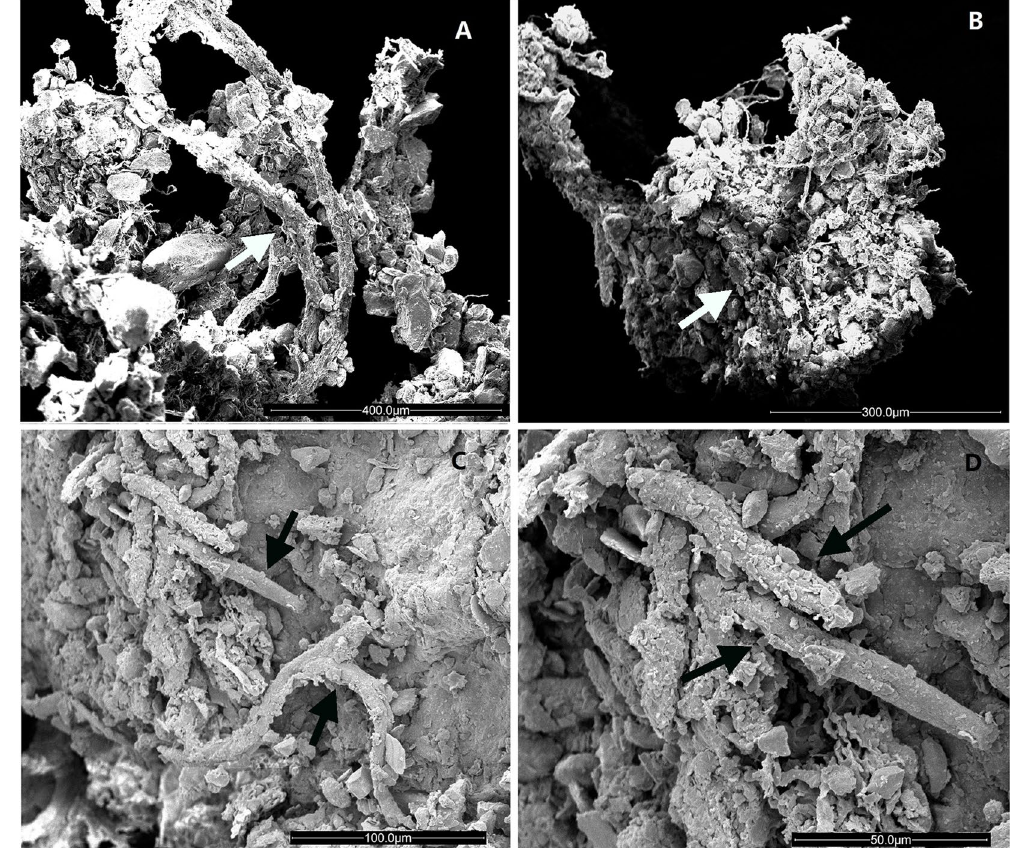
Figure 3. SEM images of thallus rhizines binding sand particles. ( A , B ) Endocarpon deserticola (holotype, Z07090); ( C , D ) Endocarpon unifoliatum (holotype, Z10020). Arrows pointing to the